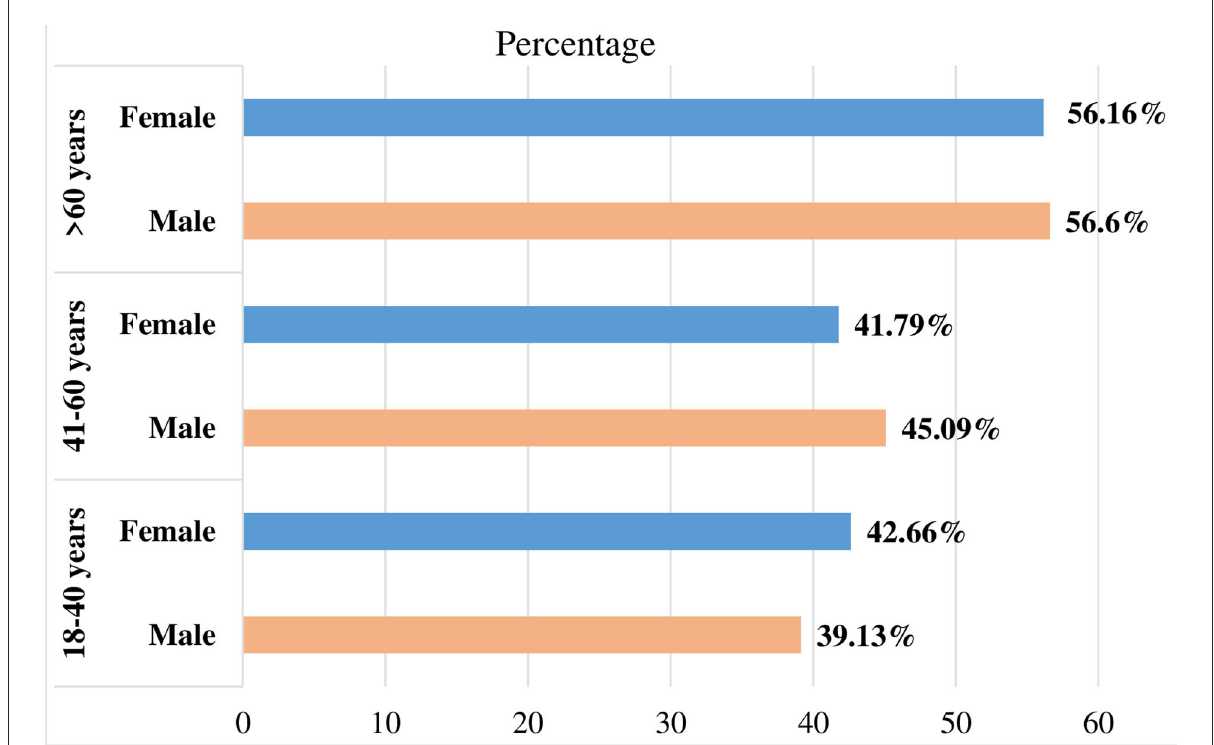
FIGURE2 Prevalence of hypertension by sex and age groups among patients in the Kiraker and Nigus Ketema primary hospitals, Northwest Ethiopia.